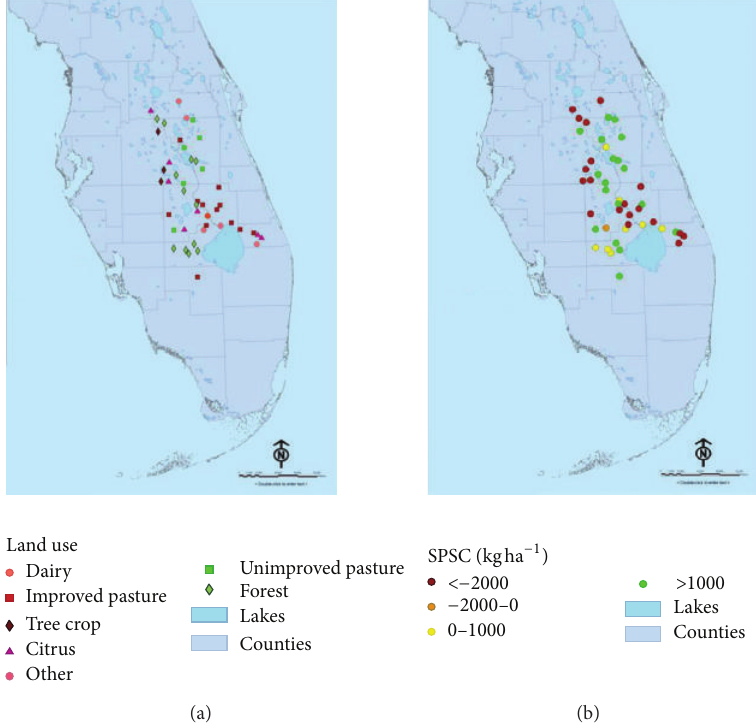
Figure 5: Land uses (a) and soil P storage capacity (SPSC; (b)) in kg ha −1 in the Lake Okeechobee Watershed of Florida, USA. Source: Showalter et al.